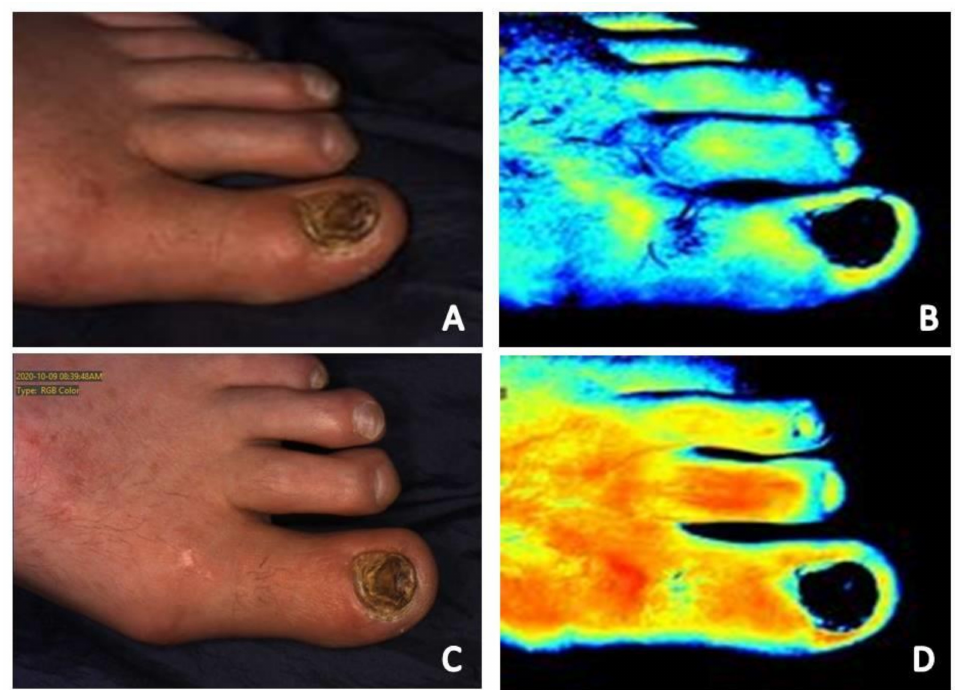
Figure 6. ( A ) Baseline clinical photograph; and ( B ) near-infrared image assessment of the left dorsal foot in a patient with arterial insufficiency referred by hyperbaric oxygen therapy. Note reduced signal to the dorsal foot ( C ) immediately prior to a single session of hyperbaric oxygen therapy and immediately following ( D ) this